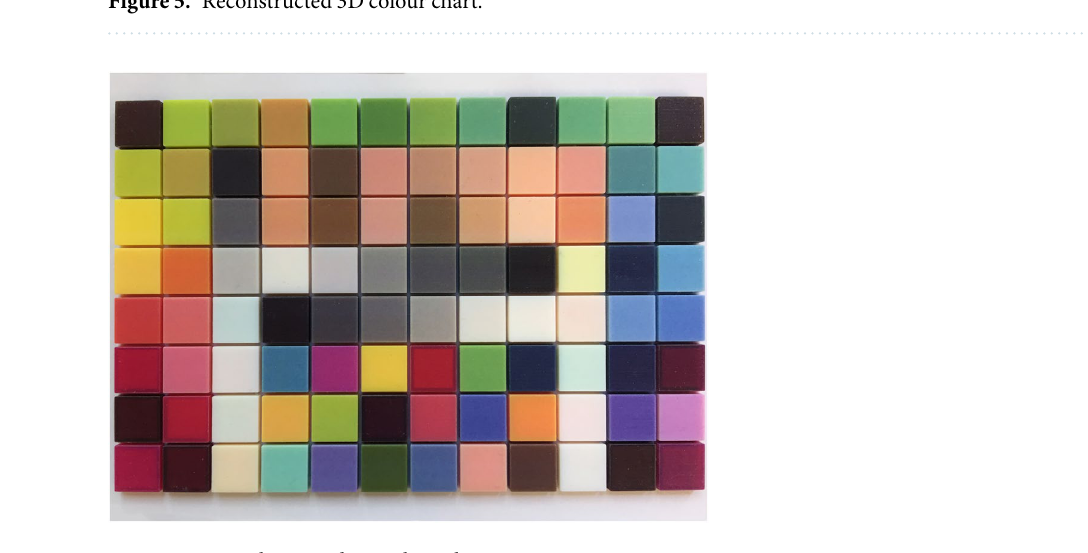
Figure 6. Directly printed 3D colour